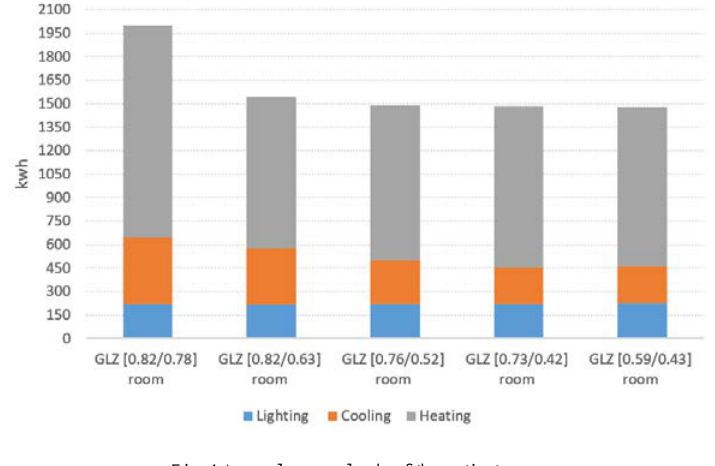
Fig. 4 Annual energy loads of the patient rooms